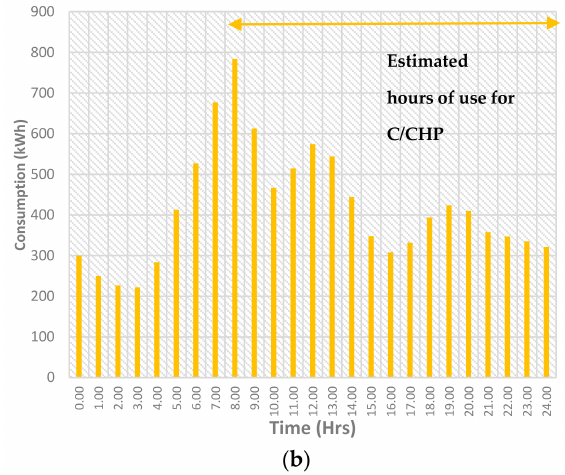
Figure 4. ( a ) Model monthly energy consumption and actual building energy consumption and ( b ) Model July hourly heat consumption.